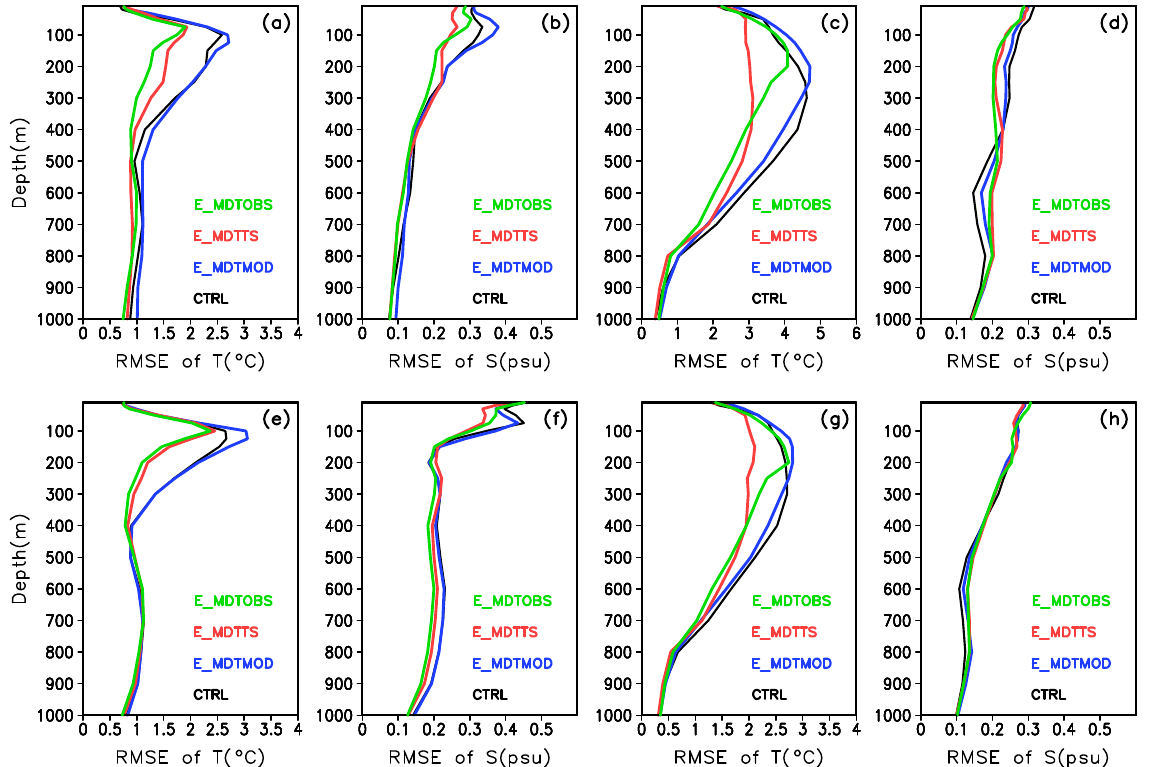
Figure 2. The root mean square errors of temperature (unit: ◦ C) and salinity (unit: psu) for the southwestern area including the Agulhas current system (a, b) , Kuroshio-current area (c, d) , the Indian Ocean (e, f) , and the Pacific Ocean (g, h) from different experiments. Black: CTRL; blue: E_MDTMOD; red: E_MDTTS; green: